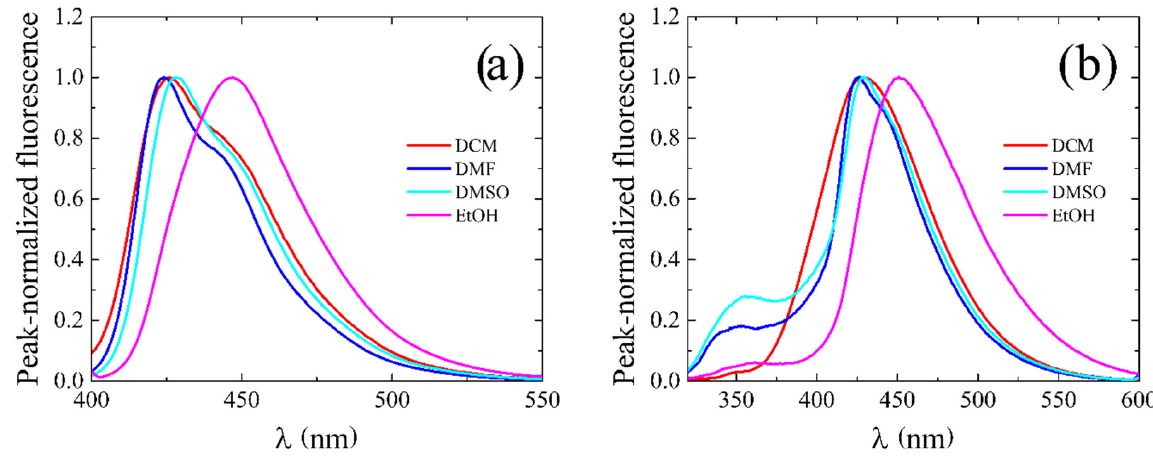
Figure 3. Fluorescence emission spectral line-shapes of 1 in different solvents upon excitation at: ( a ) the enol, and ( b ) the diketo absorption peak. Table 3. Fluorescence properties of 1 in selected solvents: peak fluorescence emission wavelengths upon excitation at the enol, λ emi,enol , and diketo, λ emi,diketo , absorption peak; peak fluorescence excitation wavelengths with fluorescence recording at the enol emission peak, λ exc,enol , and at 350 nm, λ exc,diketo ; fluorescence quantum yield of the enol tautomers,